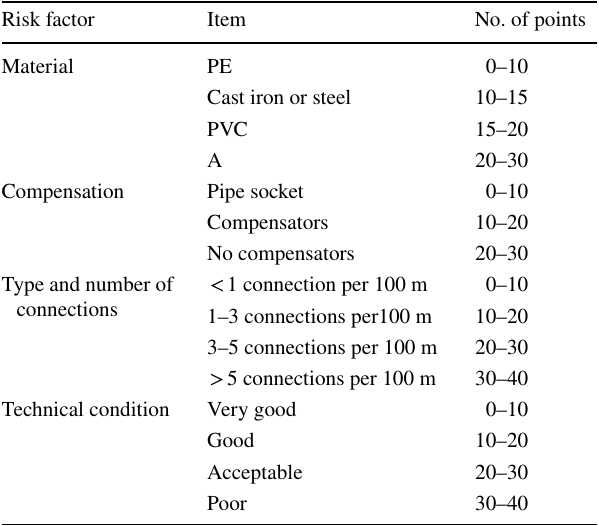
Table 2 Resistance classification of water supply networks – point method (Mendec et al. 1997)